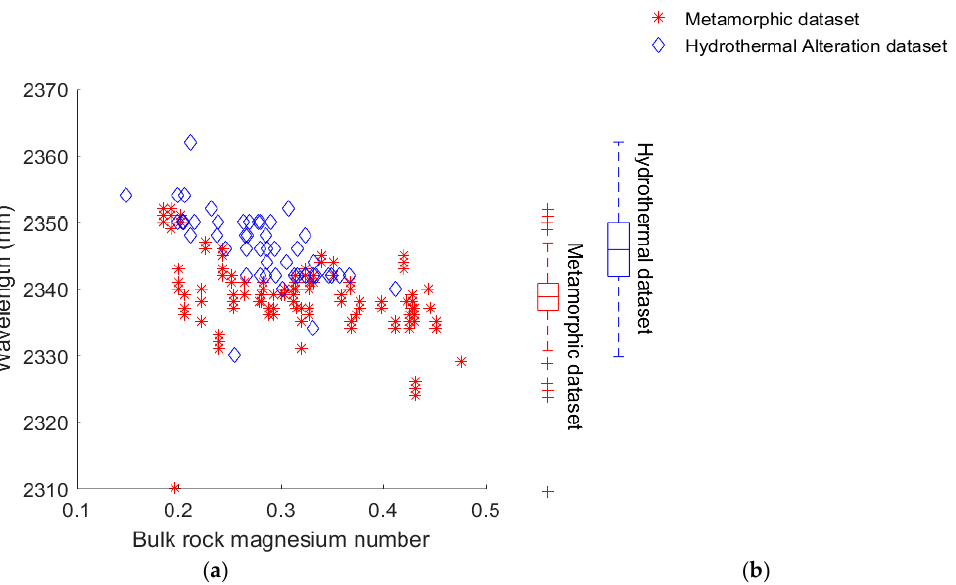
Figure 2. ( a ) Comparison of the absorption wavelength of the Mg-OH absorption feature of chlorite for both the hydrothermal and metamorphic datasets ( y -axis) and the magnesium number calculated from the bulk rock composition ( x -axis); ( b ) Boxplots show the quantiles of the absorption wavelengths for both groups of data.